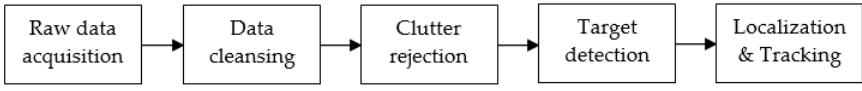
Figure 2. Signal processing steps for target detection and tracking.